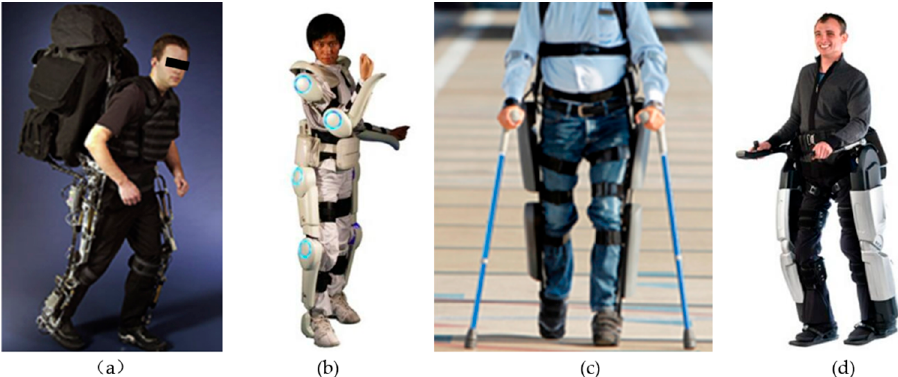
Figure 5. The wearable exoskeleton robot. ( a ) BLEEX; ( b ) Cyberdyne HAL; ( c ); Israel ReWalk; ( d ) Rex Bionics’ Rex. (( a , c ) were reproduced with permission from [72]; ( b , d ) were reproduced with permission from [73], Copyright Springer, 2013.)